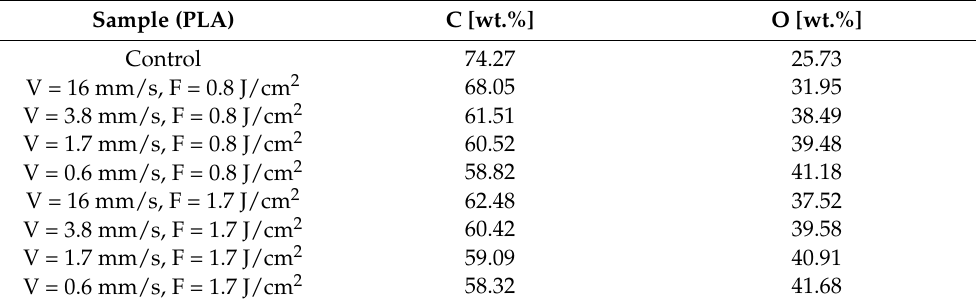
Table 1. EDX elemental composition values [wt.%] of the control and Fs laser modified PLA samples. Sample